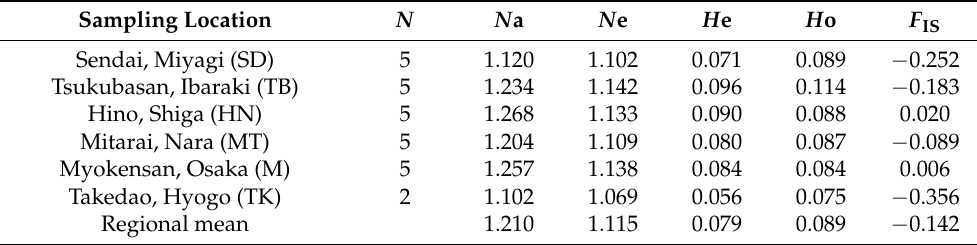
Table 3. Genetic diversity parameters of the six populations of Lindera umbellata (Lauraceae) in Japan based on 280 SNP loci. Letters in parentheses are abbreviations of sampling location.